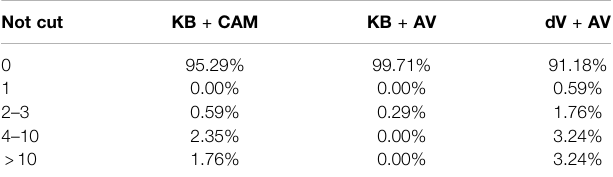
TABLE1| ResultsofMLIhatcuttingexperimentswith fi vetrainedrobotoperators, using conventional inputand visualization (KB+ CAM), conventional inputand augmented virtuality visualization (KB + AV), and da Vinci master console for input and augmented virtuality visualization (dV + AV). Success rate is quanti fi ed by percentage of cut path with given number of uncut layers. Goal was to cut all layers, so the ideal result would be 100% for 0 “ not cut ”